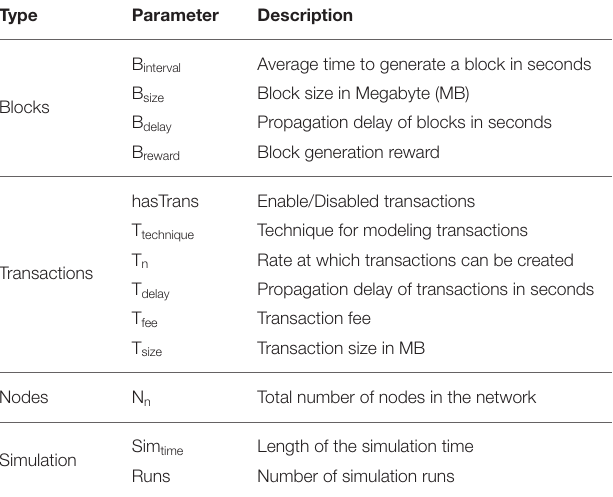
TABLE 1 | Input parameters for the